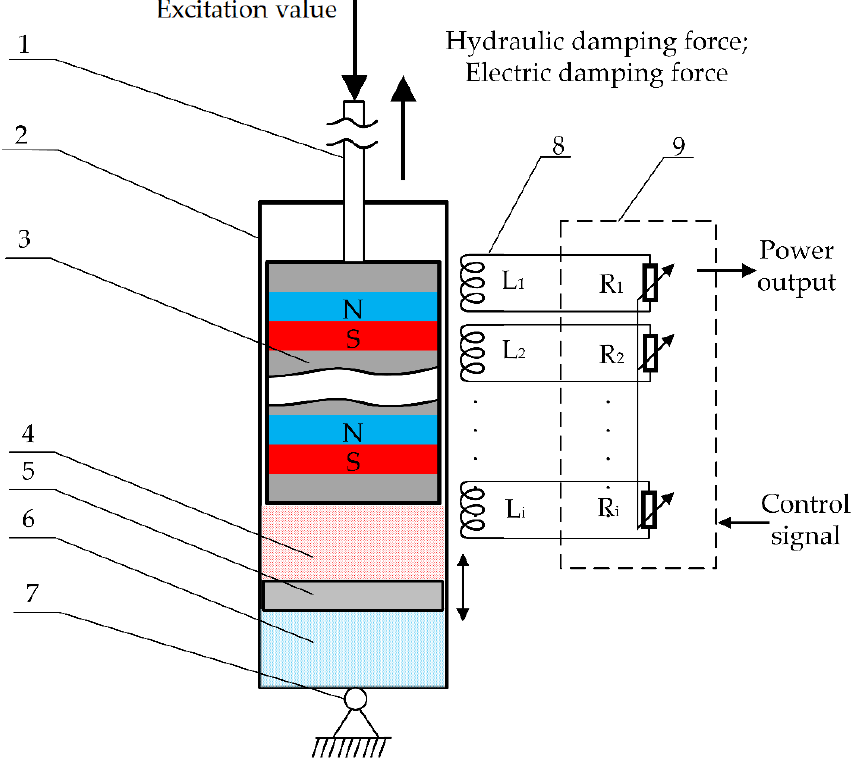
Figure 2. Conceptual prototype structure. 1 — slider rod; 2 — housing; 3 — slider; 4 — magnetorheological fluid; 5 — separating piston; 6 — air chamber; 7 — flexible fixture; 8 — coil set; 9 — power conditioning system.